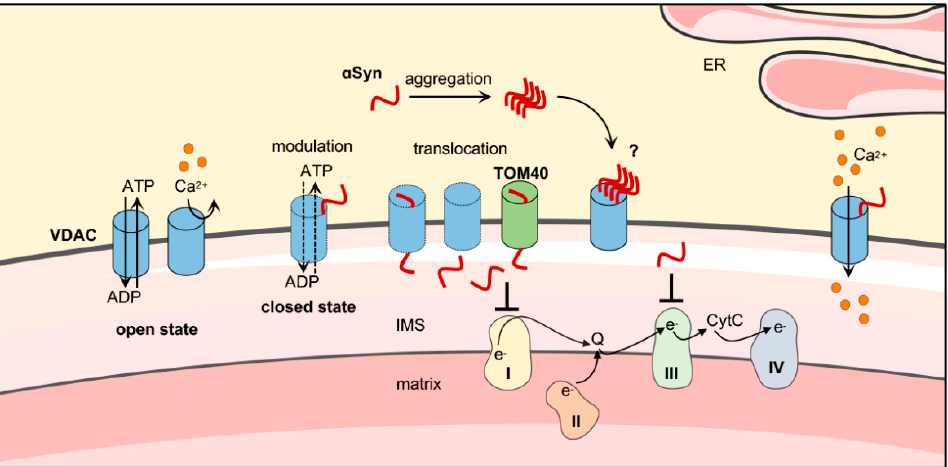
Figure 2. Proposed model of the interaction between α Syn and VDAC on the cytosolic surface of mitochondria. Monomeric α Syn binds VDAC and modulates its electrophysiological activity promoting the transition from the open to the closed state. No information is available so far about α Syn oligomers or fibrils and VDAC. The OMM β -barrel proteins, VDAC and TOM40, promote the α Syn translocation from cytosol to IMS of mitochondria, where it is believed responsible of the impairment of electron transport system complex I/III activity. Moreover, α Syn is involved in the modulation of calcium influx into mitochondria from endoplasmic reticulum (ER). Original figure created with Smart Servier Medical Art tools (https://smart.servier.com,